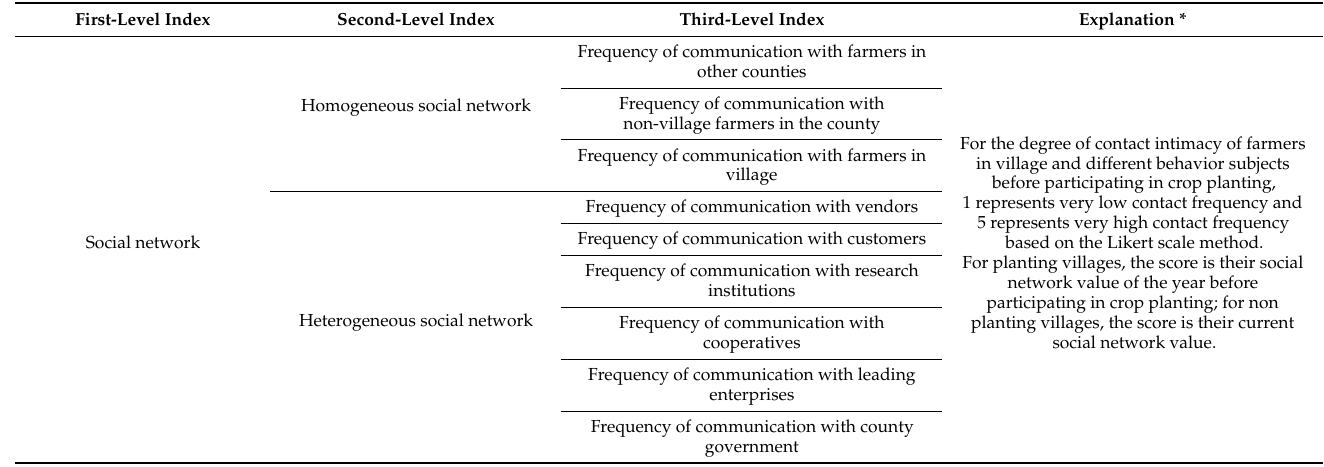
Table 1. Determinants of village social